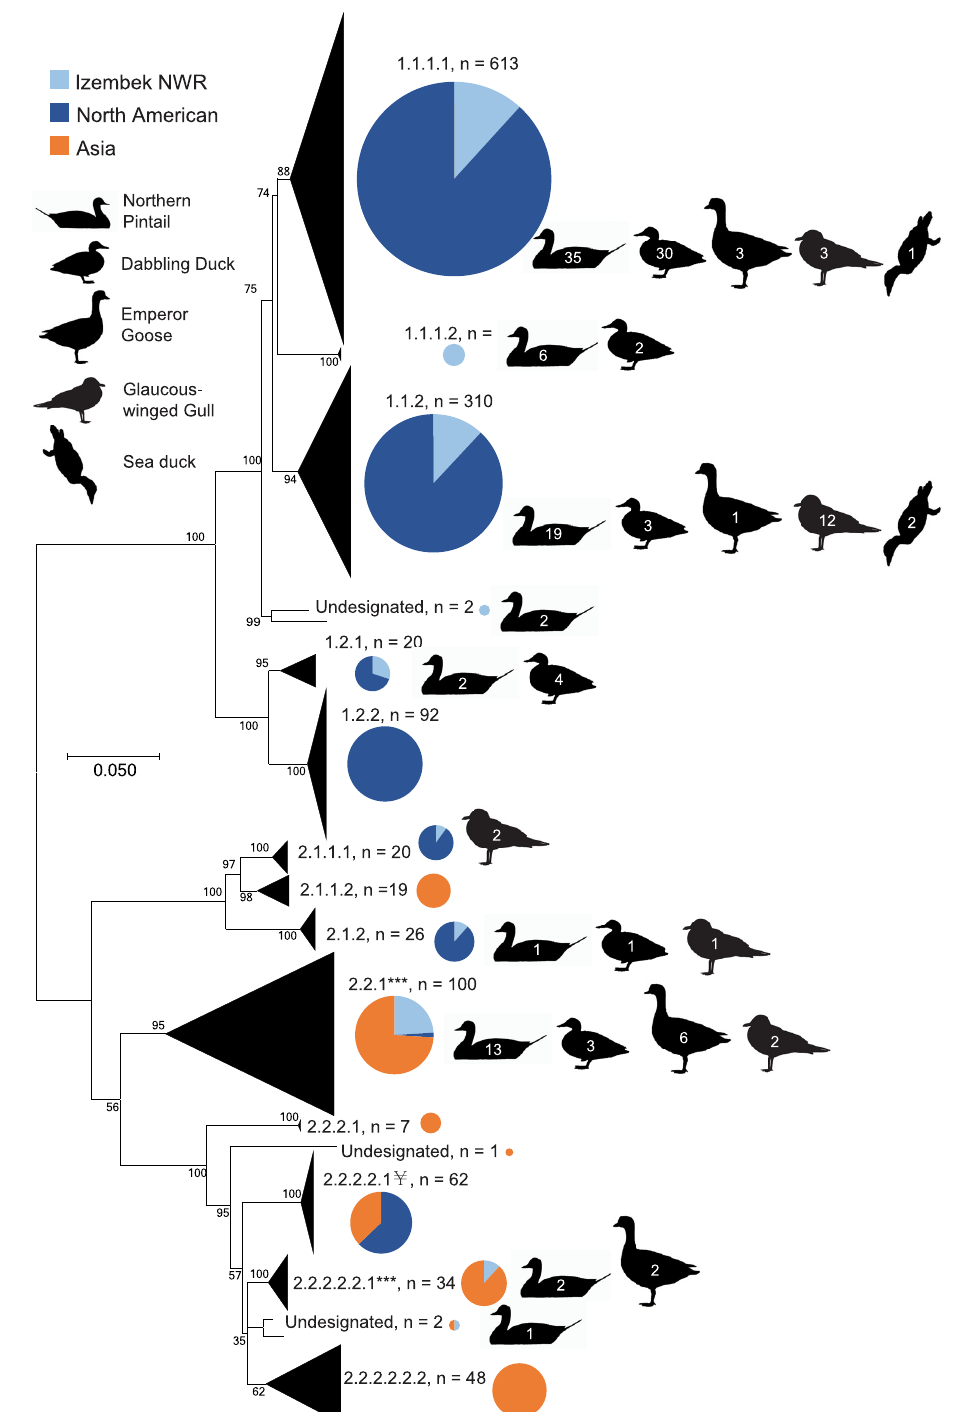
Fig 1. Phylogeny of PB2 nucleotide sequences. The Maximum Likelihood phylogeny of PB2 nucleotide sequences originating from wild bird samples collected in Asia and North America (2011–2015) including those collected from Izembek National Wildlife Refuge (NWR) and sequenced as a part of this study. This phylogeny illustrates the delineation/naming of clades for the purpose of assessing diversity of viruses across host species and the identification of lineages for which there is evidence of intercontinental viral exchange. Clades are collapsed for visualization purposes; the height of collapsed clades (triangles) 1.1.1.1 and 1.1.2 are not proportional to the rest of the phylogeny and